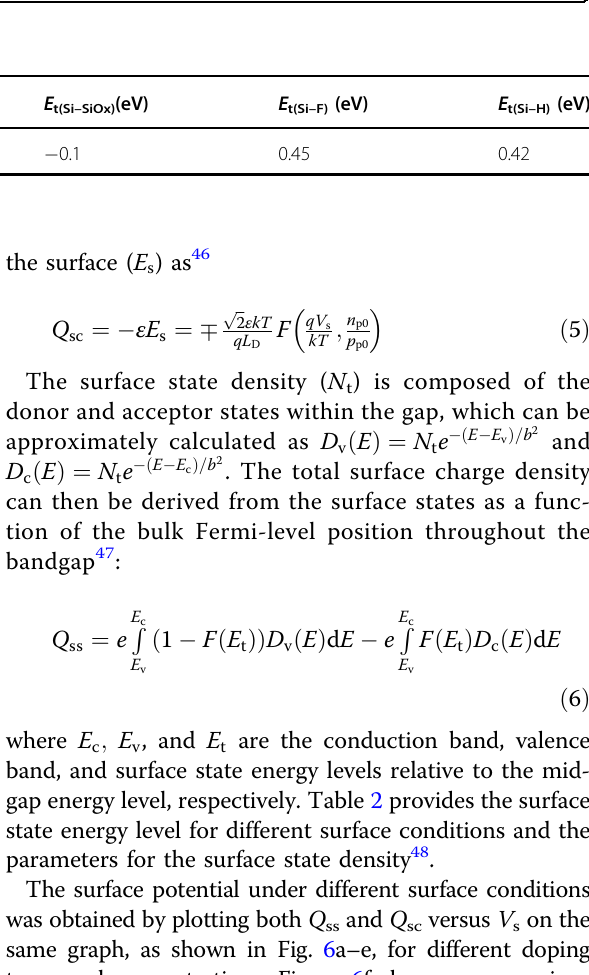
Fig. 5 Band diagrams of H-terminated Si surface. Band diagrams of the H-terminated Si surface with different doping types and concentrations: ( a ) n-type Si, ( b ) n − -type Si, ( c ) undoped Si, ( d ) p − -type Si, and ( e ) p-type Si. Because of the surface dipoles from the H – Si bond at the surface, the surface state energy level changes with + δ and leads to surface band bending